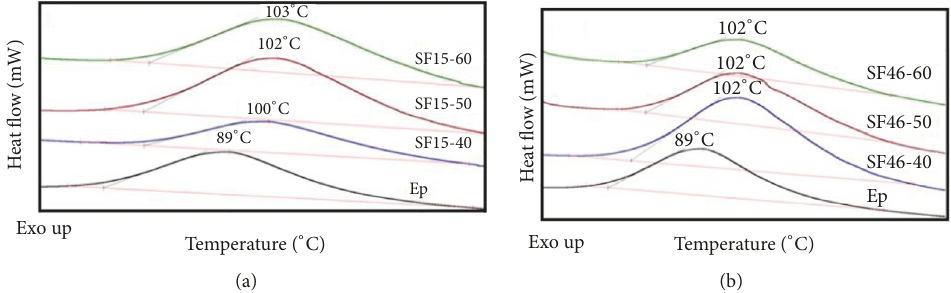
Figure 5: Nonisothermal DSC traces for epoxy-HGM formulations with increasing glass microballoons loadings: (a) SF15 and (b)